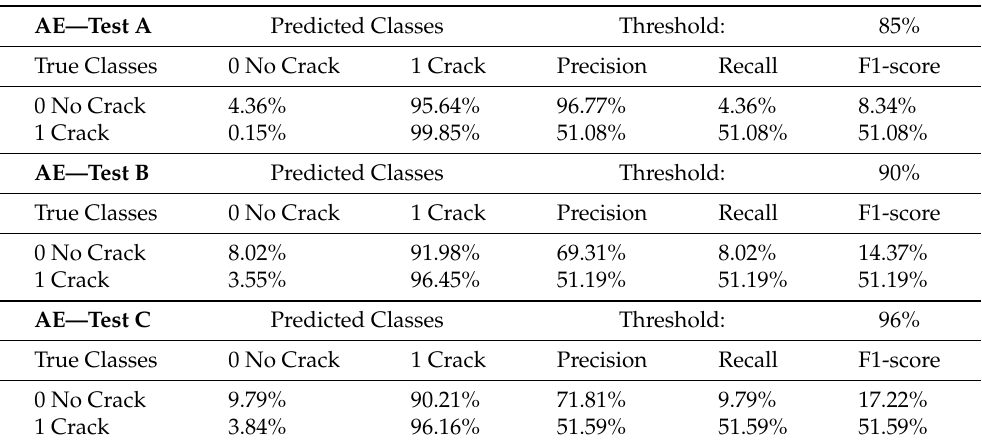
Figure 7. SED trained on seismic data only. Upper pane, crack class probability threshold evaluation, lower pane onset time predictions in terms of frames on the test set (82 seismic data) for optimal threshold. From left to right, PLB test A (optimal threshold of 85%), B (optimal threshold of 90%), and C (optimal threshold of 96%). Table 3. Confusion matrix and classification metrics for SED trained on seismic data only, tested on the AE datasets (100 signals for 3 setups A, B, and